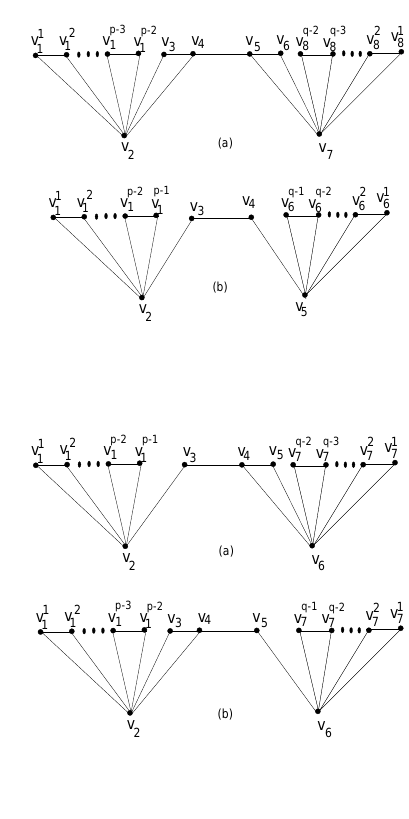
Figure 2: (a) C 2 ( p , q ) and (b) C (cid:48) 2 ( p , q )